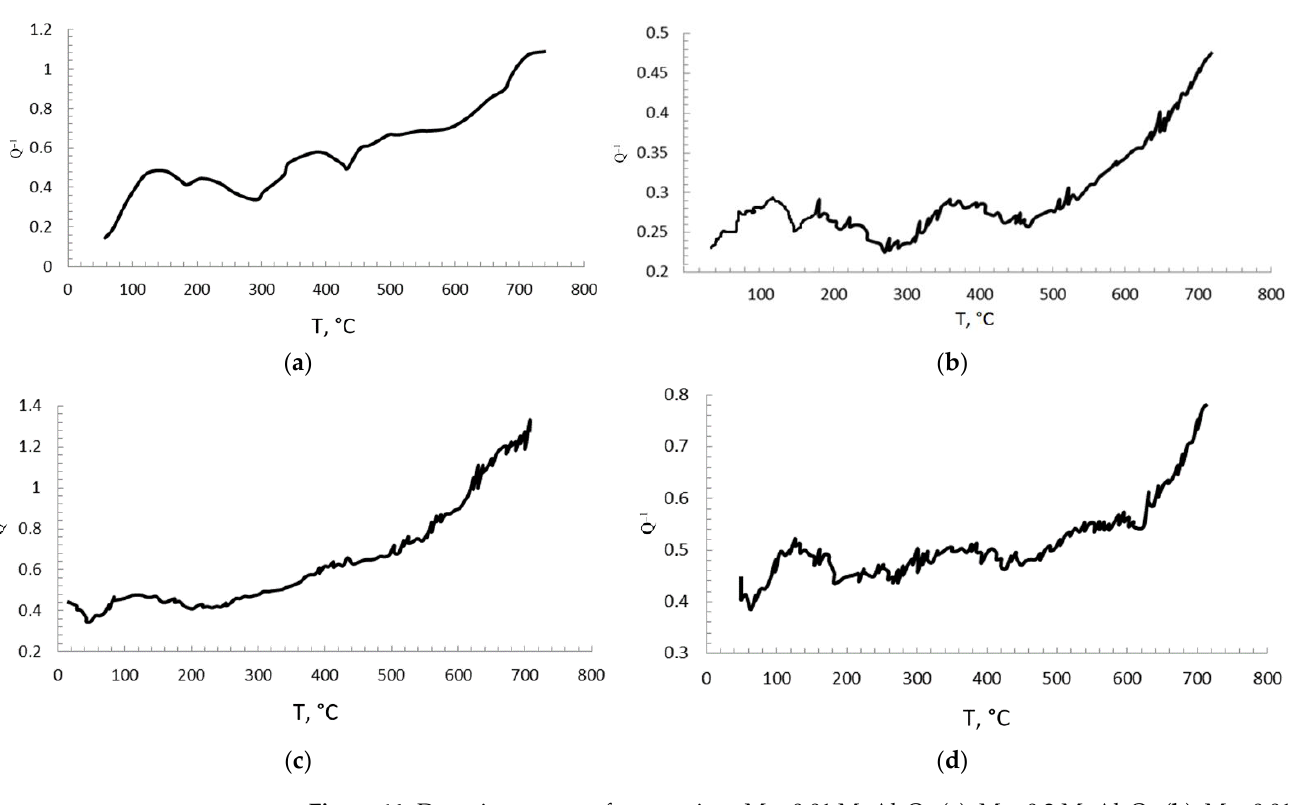
Figure 14. Damping curves of composites: M + 0.01 MgAl 2 O 4 ( a ), M + 0.2 MgAl 2 O 4 ( b ), M + 0.01 ZrO 2 ( c ), M + 0.1 ZrO 2 ( d